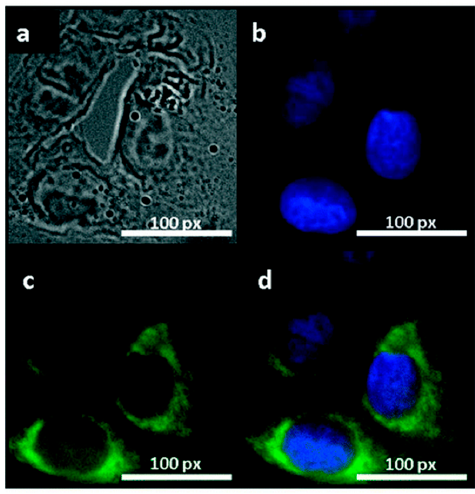
Figure 2. Fluorescent images of human breast cancer cell T47D after incubation with green GQDs for 4 h ( a ) phase contrast picture of T47D cells; ( b ) Individual nucleus stained blue with DAPI; ( c ) Agglomerated green GQDs surrounding each nucleus; ( d ) The overlay high contrast image of nucleolus stained with blue DAPI and GQDs (green) staining. Reproduced with permission [61] Copyright 2012, American Chemical Society.